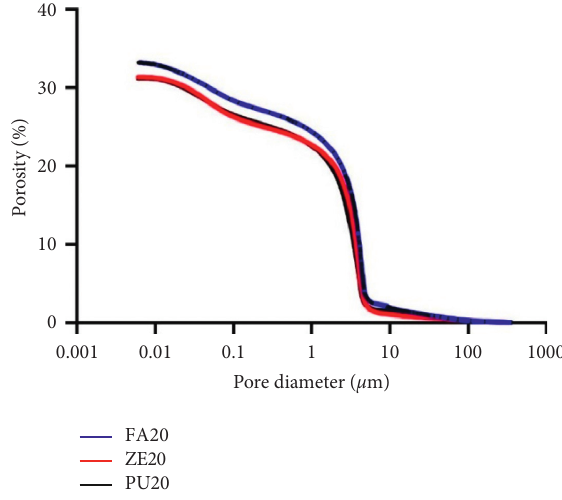
Figure 9: Cumulative porosity of natural pozzolans samples.